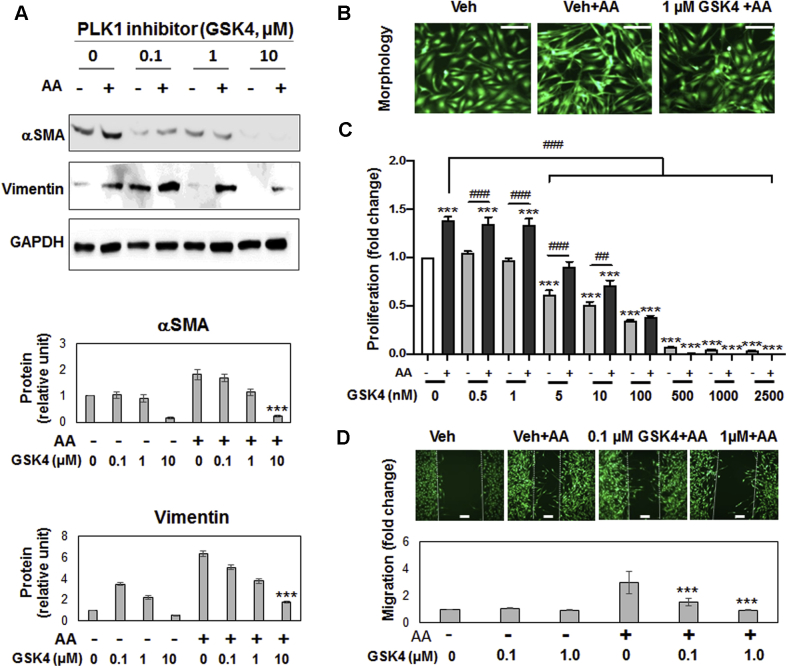
PLK1 Inhibition Blocks PDGF-AA–Stimulated Fibroblast Cell-Type TransitionExperiments were performed as described in Figure 1 except that the PLK1-selective inhibitor GSK461364 (GSK4) was used for pretreatment before AA stimulation. (A) Western blots of αSMA and vimentin. (B) Morphologic comparison. Cells were (or were not) stimulated by AA for 24 h without or with pretreatment (1 μmol/l GSK4). (C) Proliferation. CellTiter-Glo assay was performed after 72 h stimulation (by AA or solvent) without or with pretreatment with GSK4 at increasing concentrations. (D) Migration (scratch assay). Cells were (or not) stimulated by AA for 24 h without or with pretreatment (0.1 or 1 μmol/l GSK4). Mean ± SEM, n ≥3 experiments, 1-way ANOVA/Bonferroni test: #p < 0.05; ##p < 0.01; ###p < 0.001. ∗p < 0.05; ∗∗∗p < 0.001 compared with vehicle control without AA (C) or with AA (A, D). Abbreviations as in Figure 1.